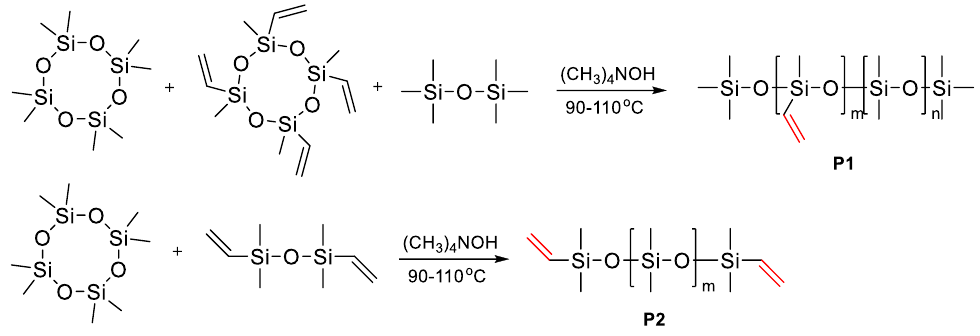
Figure 16. Synthesis of the functionalized polysiloxanes (P1, P2).